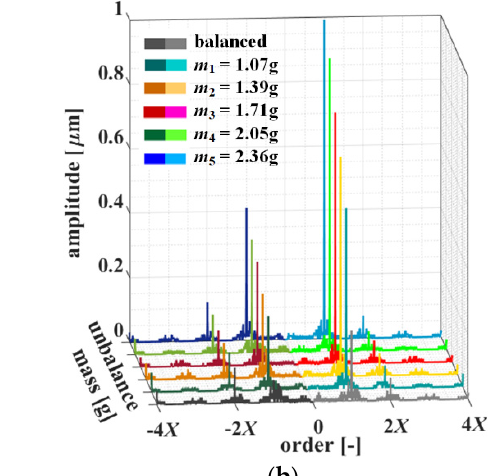
Figure 11. Spectra of FS analysis as a function of unbalance mass, m n , for speeds n 1 = 300 rpm ( a ) and n 6 = 1500 rpm ( b ).